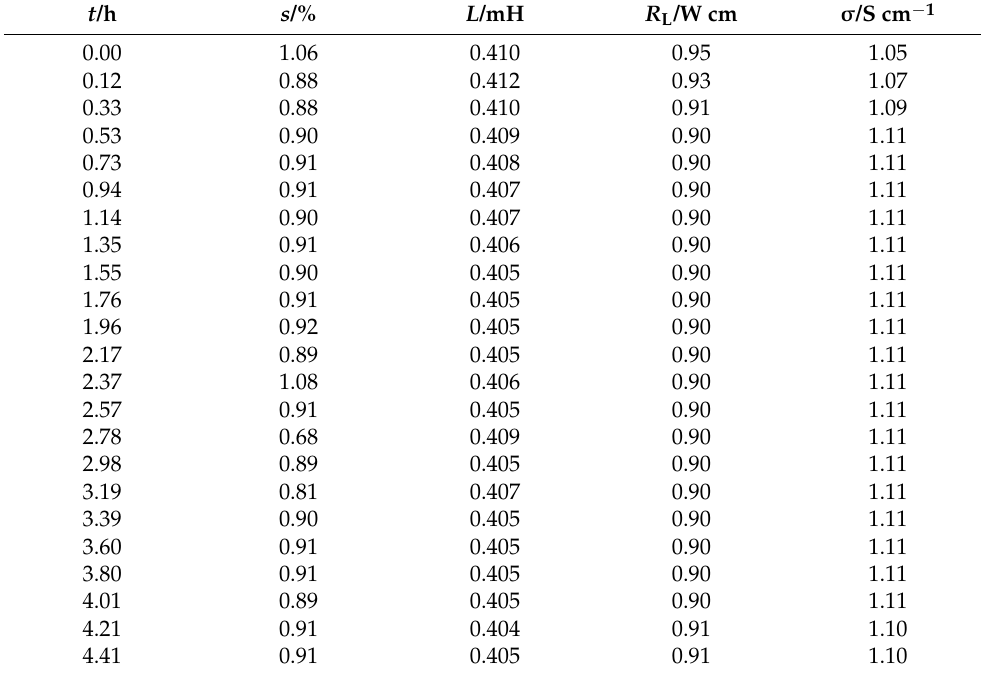
Table 3. Results of fitting the impedance spectra recorded for Ni–5CBCY during the first reduction in 5% H 2 –Ar gas atmosphere ( t —time elapsed from the beginning of the experiment; s —standard deviation; fitted parameters (for the electrical equivalent circuit (EEC) presented in Figure 14a): L —inductance; R L —resistance; σ —electrical conductivity). t /h